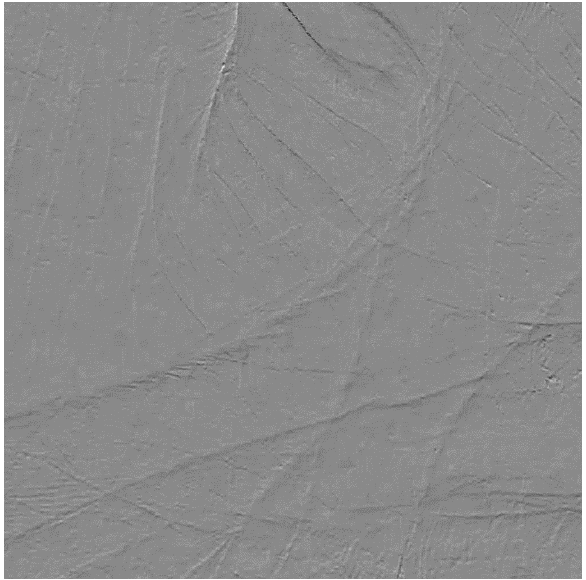
Figure 2. Differential image calculated by pixel accuracy alignment using cross correlation which contains some noise because of sub pixel error.